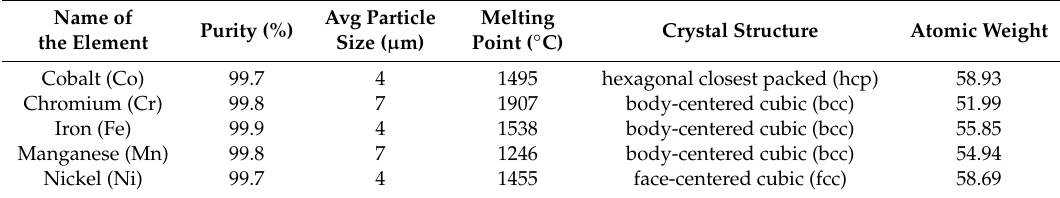
Table 1. Details of the elemental powders used for the synthesis of single phase high-entropy alloys (HEA).